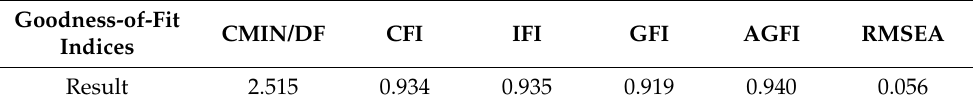
Figure 3. Partial mediating effect of negative affect experience between the rejection parenting style and the perceived cyberbullying. Table 6. The model fitting goodness index table with the perceived cyberbullying as the dependent variable.